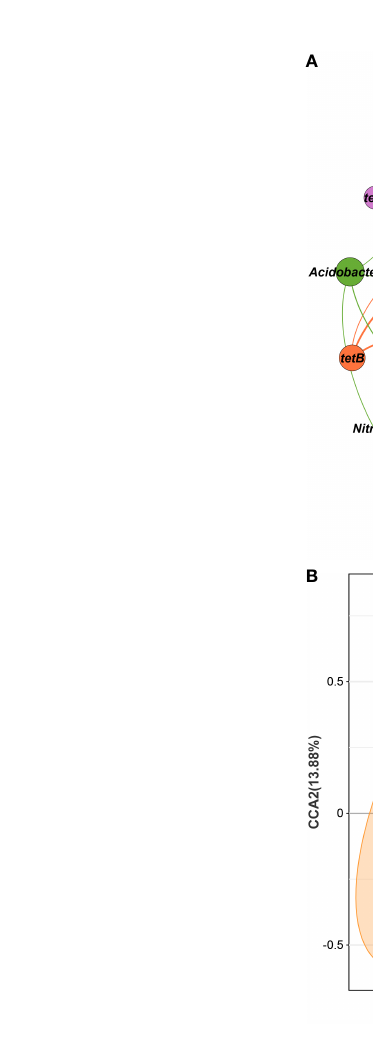
FIGURE 7 Correlations among the bacterial community, ARGs, and environmental factors. (A) Network analysis of ARGs and bacterial communities at the phylum level in the pond water. The linkage between the nodes indicates a correlation between the two factors, and the size of the node is proportional to the number of connections. At the same time, the thickness of the line was proportional to the correlation between the factors. (B) Canonical correspondence analysis of the environmental factors and bacterial communities at the phylum